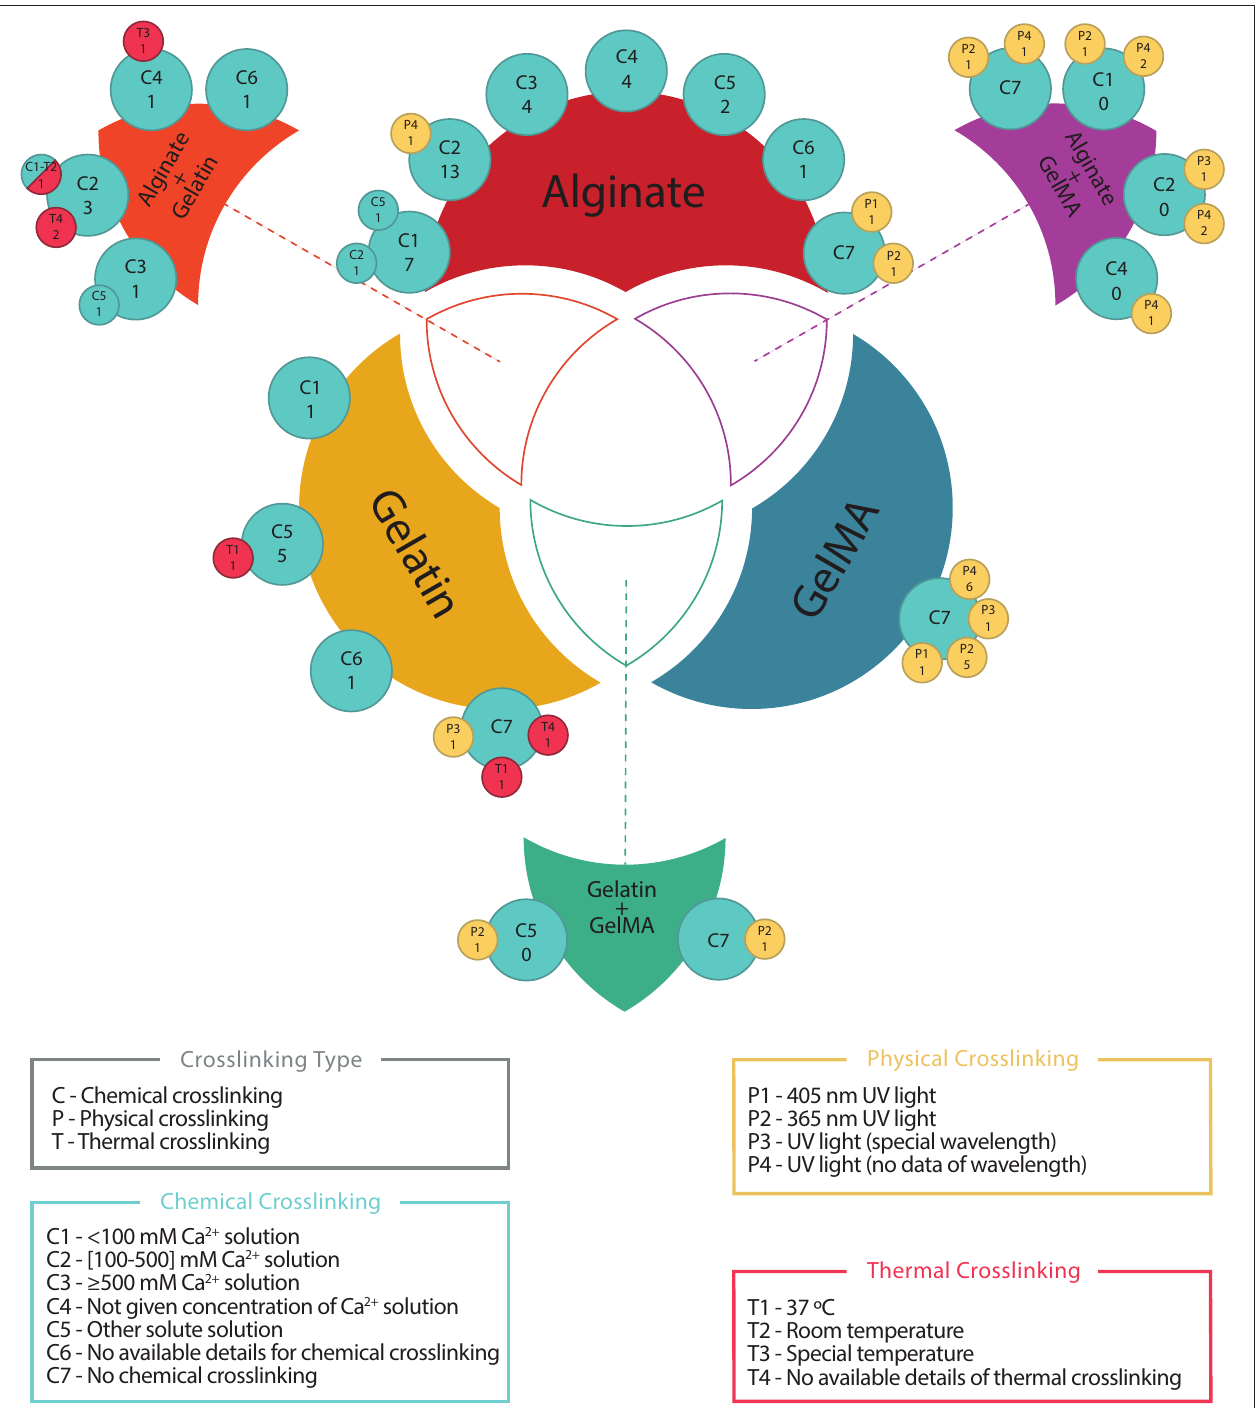
FIGURE 7 | Cross-linking used for the three most common materials and its combinations. Blue, yellow, and red circles represent chemical, physical and thermal cross-linking, respectively. Superposed circles indicate that two cross-linking classifications have been combined. Each circle contains a classification codification (upper code) and the number of papers for the corresponding code combination (lower number). Chemical cross-linking has been chosen as primary classification, therefore papers not using it have been codified under C7 for graphical representation purposes and no papers are allocated to this code alone, e.g., alginate C2/13 – P4/1 (blue and yellow circles superposed) indicates that 13 papers used C2 ([100–500] mM Ca 2 + solution) to cross-link alginate and another paper used C2 and P4 (UV light—no data of wavelength) to perform the cross-linking.